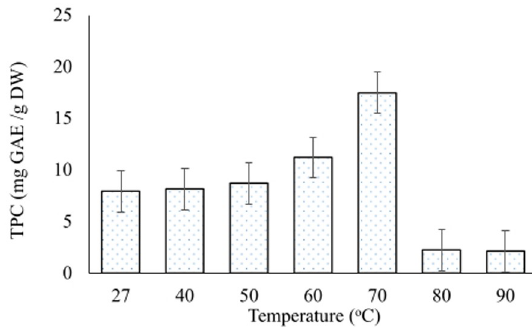
Fig 1. Effect of temperature on extraction of total